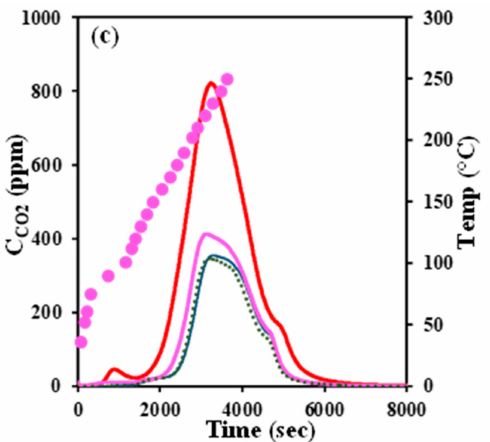
Figure 6. ( a ) Breakthrough curves of Hopcalite at di ff erent initial toluene concentration (dotted line corresponds to the concentration of toluene) ( b ) TPD profile of toluene ( c ) TPR profile of CO 2 (circle represent the temperature). Table 3. Adsorption (ADS) and desorption (DES) reaction of toluene on Hopcalite in He atmosphere. Toluene Initial Concentration